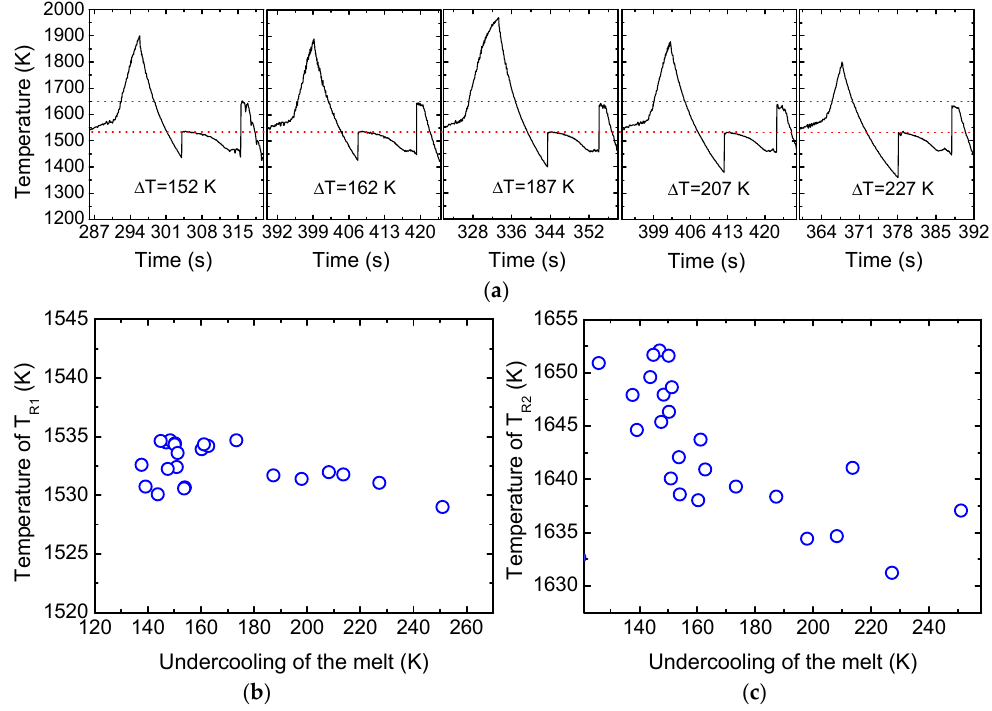
Figure 2. ( a ) Illustration of time-temperature profiles for different undercoolings. Changes of the recalescence temperature for ( b ) primary (CoSi 2 ) and ( c ) secondary (CoSi) phases as a function of undercooling of the melt.